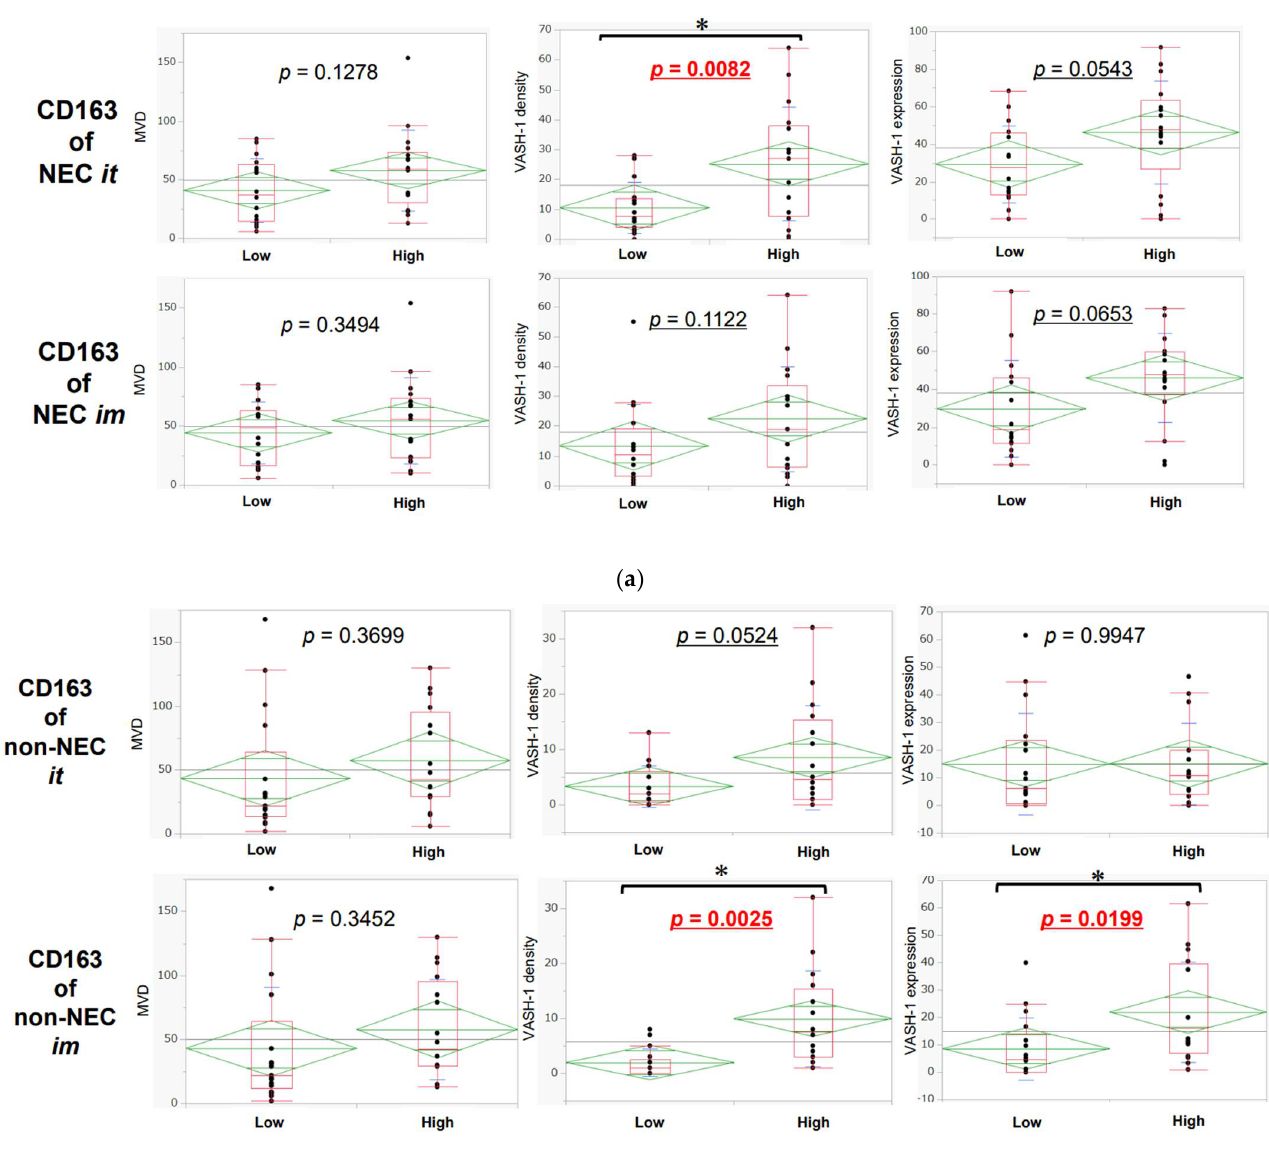
Figure 7. ( a ) Association between the number of CD163-positive macrophages infiltrating intra-tumoral areas and invasive margins in NEC components ( t -test). The number of CD163-positive macrophages was significantly associated with the VASH-1 density and immunoreactivity and tended to be associated with an increased MVD. The points are outliers. * it: intra-tumoral, im: invasive margin; cutoff: median. ( b ). Association between the number of CD163-positive macrophages infiltrating the intra-tumoral areas and invasive margins in non-NEC components ( t -test). The high infiltration of CD163-positive macrophages was significantly associated with the VASH-1 density and immunoreactivity, but not with the MVD. The points are outliers. * it: intra-tumoral, im: invasive margin; cut off: